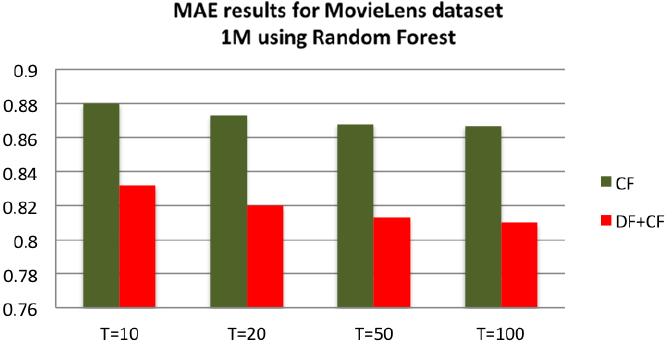
Fig. 3. MAE results for the MovieLens dataset using random